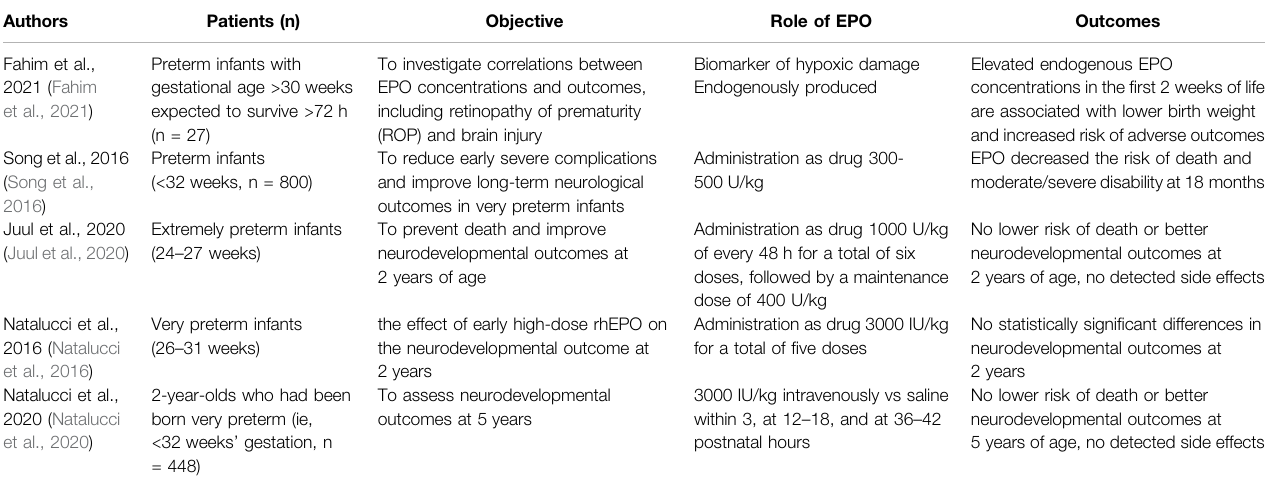
TABLE 2 | Studies involving EPO administration in preterm infants without